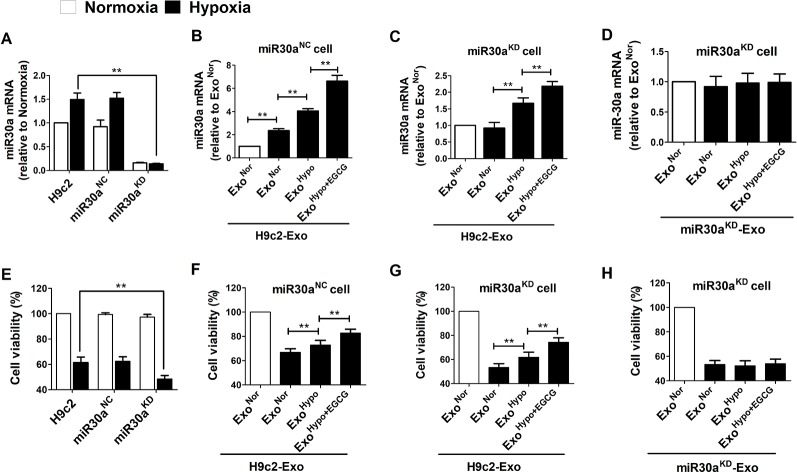
Exosomes derived from EGCG-treated cells led an increase of miR30a expression in a paracrine manner and improved cells vitality. (A) Total RNA from H9c2, miR30aNC and miR30aKD cells in normoxia and hypoxia conditions were extracted and subjected to qRT-PCR to detect the levels of miR30a. (B) MiR30aNC cells were treated with exosomes (50 μg/mL) derived from H9c2 in normoxia conditions (ExoNor), hypoxia conditions (ExoHypo) or EGCG-treated hypoxia conditions (ExoHypo+EGCG). The expression levels of miR30a in each group were determined with qRT-PCR. (C) MiR30aKD cells were treated with exosomes (50 μg/mL) derived from H9c2 in normoxia conditions (ExoNor), hypoxia conditions (ExoHypo) or EGCG-treated hypoxia conditions (ExoHypo+EGCG). The expression levels of miR30a in each group were determined with qRT-PCR. (D) miR30aKD cells were treated with exosomes (50 μg/mL) derived from miR30aKD cells in normoxia conditions (ExoNor), hypoxia conditions (ExoHypo) or EGCG-treated hypoxia conditions (ExoHypo+EGCG). The expression levels of miR30a in each group were determined with qRT-PCR. (E–H) Cell viability in each group was determined by CCK-8 assay, the grouping was the same as A-D respectively. Values were expressed as mean ± SD (n = 6). ANOVA testing was performed; **p < 0.01 vs. other group.